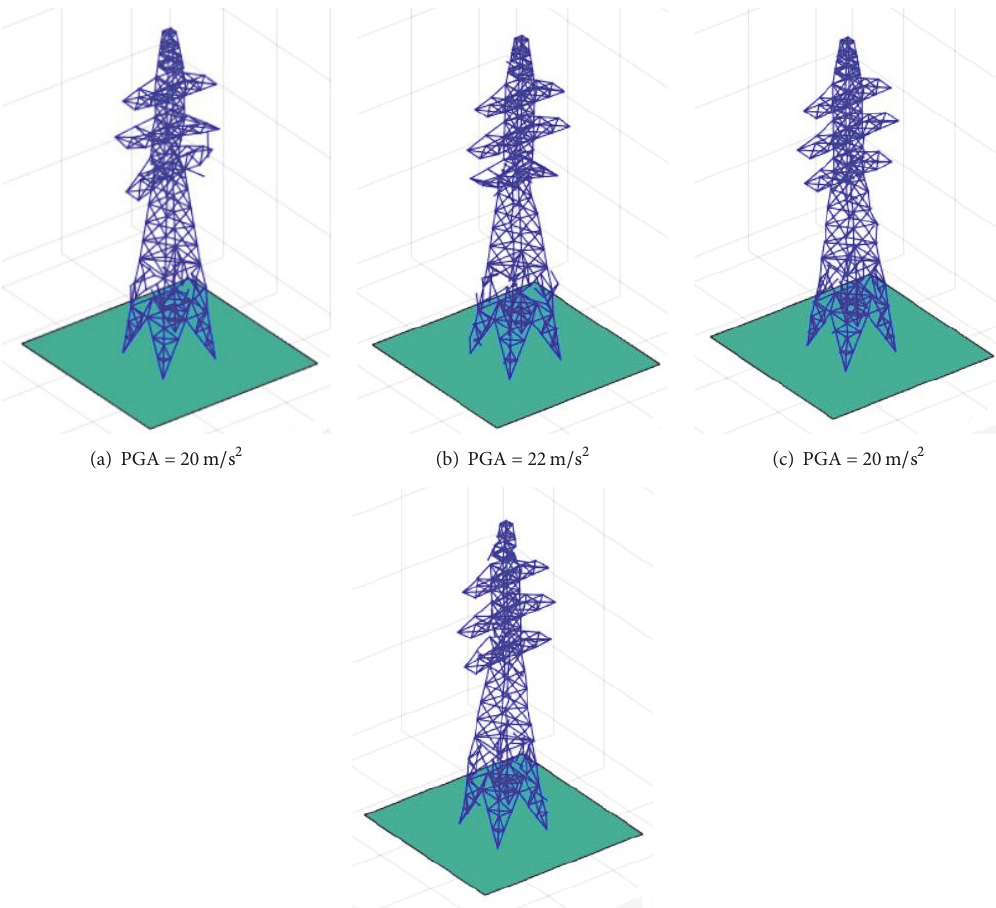
Figure 17: Damage drawing of the transmission tower under different